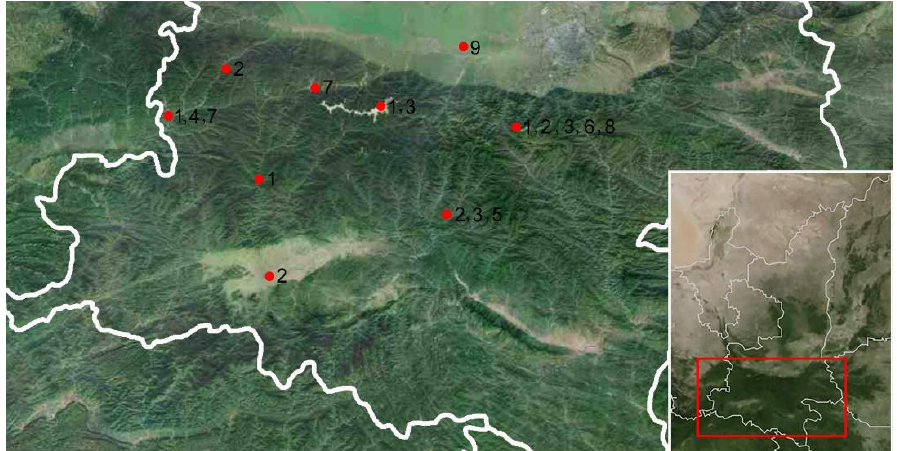
Figure 1. Geographical distribution of Batracomorphus species in Qinling Mountain of Shaanxi. As shown in the figure: 1. B. allionii (Turton); 2. B. pandarus ; 3. B. subfuscus (Li and Wang); 4. B. juno Knight rec. nov.; 5. B. fletcheri sp. nov.; 6. B. lateprocessus Li and Wang; 7. B. clavatus Cai and Shen; 8. B. lunatus Cai and He; 9. B. geminatus (Li and Wang).